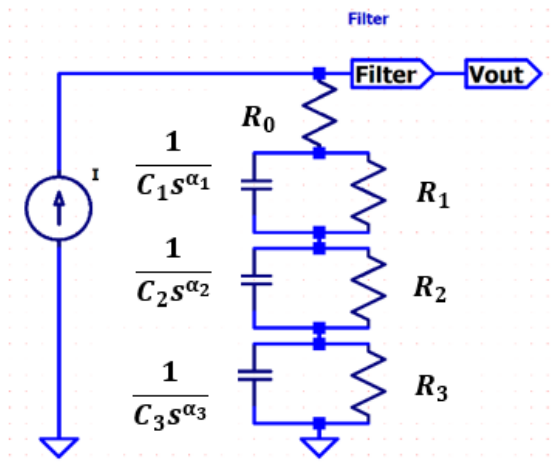
Figure 3. Proposed triple-dispersion Cole model. The filter, F , accounts for the used filter for processing the automatically detected contractions [48].